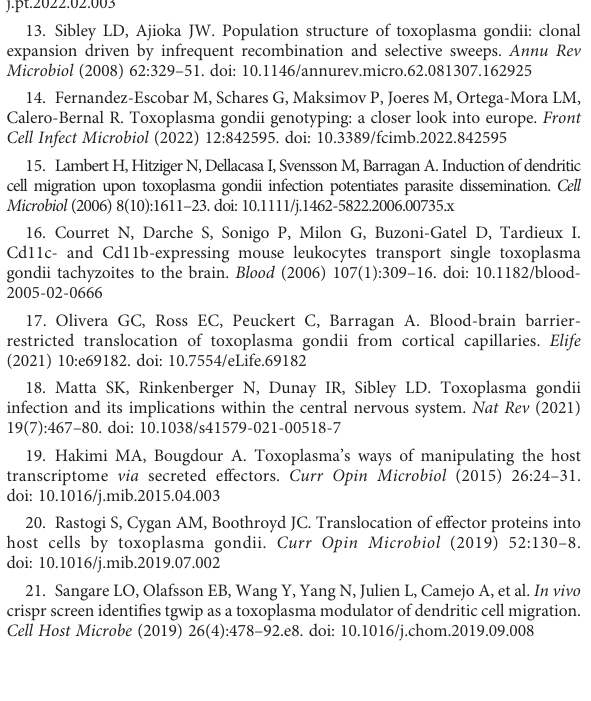
SUPPLEMENTARY FIGURE 1 Infection frequency and assessments of polarisation and barrier integrity for transmigration assays. (A) Infection frequency of DCs challenged with type I or type I T. gondii at MOI 2 for 4 h. (B) TEER values of bEnd.3 cells relative to TEER valuesat initiation of the assay (100%), in . (C) Permeability of bEnd.3 cell monolayers to FITC-dextran (3 kDa) following TEM in . (D) Relative expression of ICAM-1 (CD54) at 24 h post-challenge of CD11c + cells with type II (PRU) T. gondii tachyzoites (WT or D MYR1, MOI 1), assessed by fl ow cytometry. Mean fl uorescence intensity (MFI) was related to that of unchallenged CD11c + in complete medium (CM, normalised to 1). Bar graphs represent the mean ± s.e.m of 3-4 independent experiments. ns: non-signi fi cant, by one-way ANOVA, Sidak ’ s post-hoc test. SUPPLEMENTARY FIGURE 2 Transduction of primary DCs. Representative micrographs of mock- treated DCs (Mock) and eGFP-expressing DCs transduced with shLuc or shICAM-1, as described in materials and methods. Transduction ef fi ciency was consistently 30-40% based on eGFP expression. Scale bar =